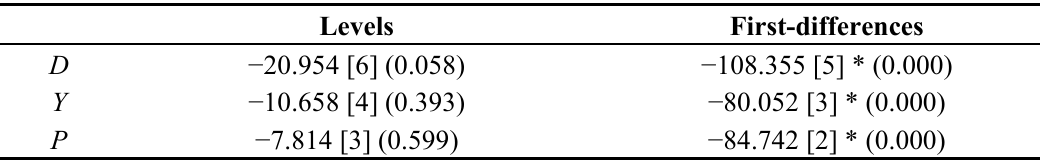
Table 3. Results of Phillips-Perron unit root